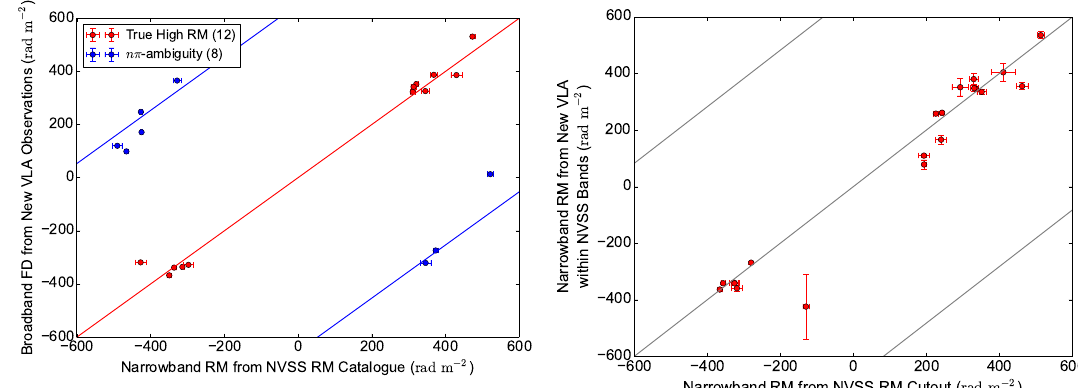
Figure 1. Left Faraday depths (FDs) from new Very Large Array (VLA) observations plotted against the rotation measure (RM) values in the NVSS RM catalogue. The data points should lie near the red line if FD/RM values from the two studies agree with each other (i.e., they are truly high-RM sources), or near one of the blue lines if they suffer from 1 π -ambiguity in the NVSS RM catalogue. Right RM from our new VLA observations using only the NVSS frequency bands against that obtained from NVSS RM cutout images. Both sets of RM values are obtained from performing the traditional λ 2 fit, with n π -ambiguity resolved using the broadband FD